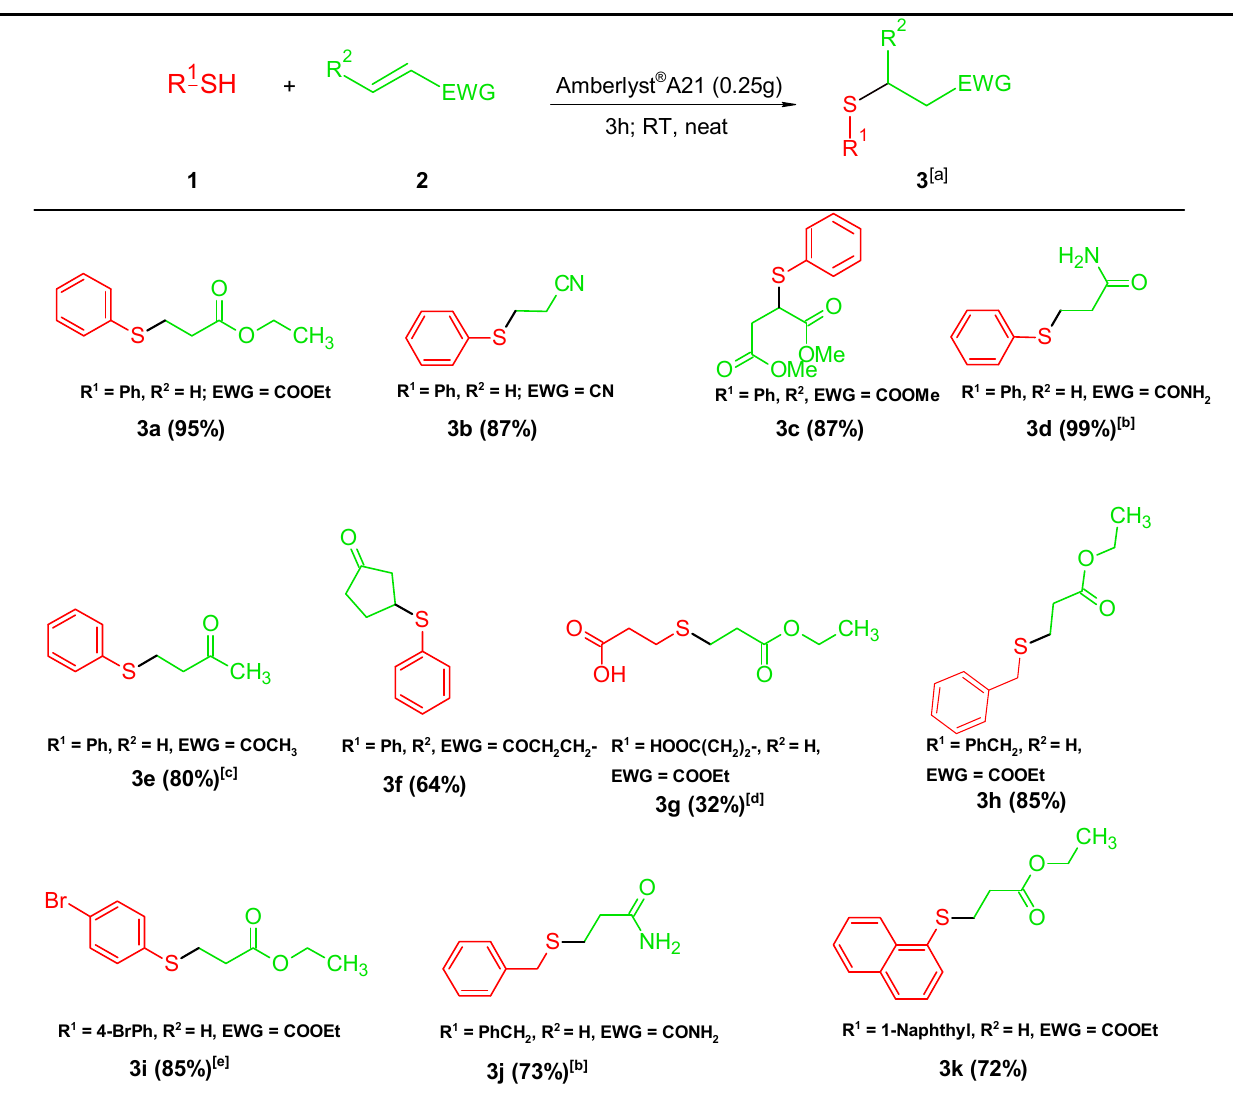
Figure 3. Substrate scope expansion for the thia-Michael reaction catalyzed by Amberlyst ® A21